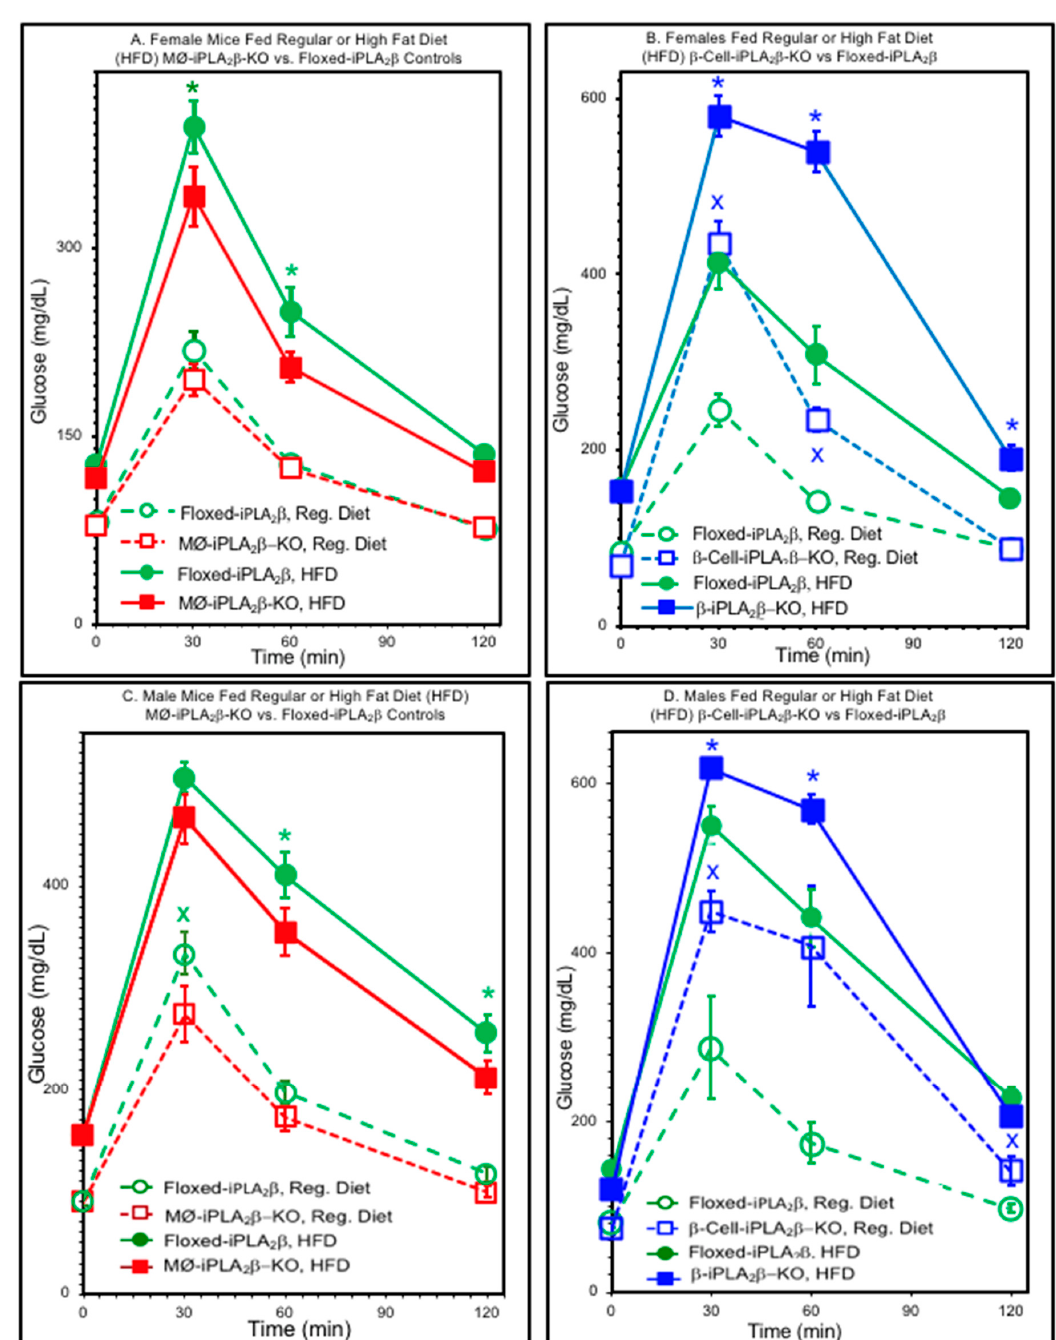
Figure 2. Glucose tolerance tests for iPLA 2 β conditional knockout mice and floxed-iPLA 2 β controls. D-glucose (2 mg / g body weight) was administered by intraperitoneal injection to female ( A,B ) or male ( C , D ) floxed-iPLA 2 β control mice (circles), MØ- iPLA 2 β -KO mice ( A , C , squares), or β -cell-iPLA 2 β -KO mice ( B , D , squares) 6 months of age that had been fed a regular diet (open symbols) or high-fat diet (HFD, closed symbols) after the age of 8 weeks, and blood was collected at baseline and at 30, 60, and 120 min after glucose administration to measure blood glucose concentration. Values are displayed as means ± SEM (n = 6 to 24, as specified by condition in Table S1). An asterisk (*) denotes p < 0.05 for comparisons between genotypes. The symbol x denotes p < 0.05 for the comparison between diets.